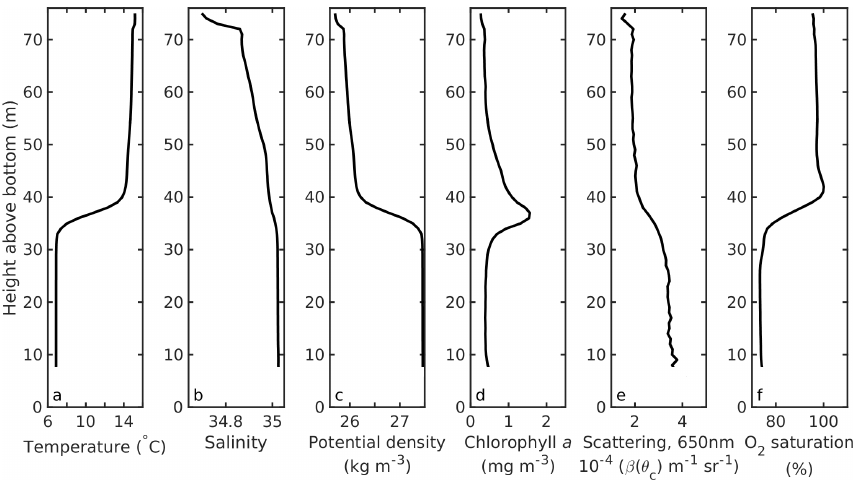
Figure 4. Mean profiles as observed by the Seaglider of temperature ( a ; ◦ C), salinity ( b ; PSU), potential density ( c ; kgm − 3 ), chlorophyll a concentration ( d ; mgm − 3 ), optical scattering as a volume scattering function at 650nm ( e ; × 10 − 4 β(θ c ) m − 1 sr − 1 ), and oxygen saturation ( f ; %) as height above the seabed. Daytime profiles were omitted for chlorophyll a